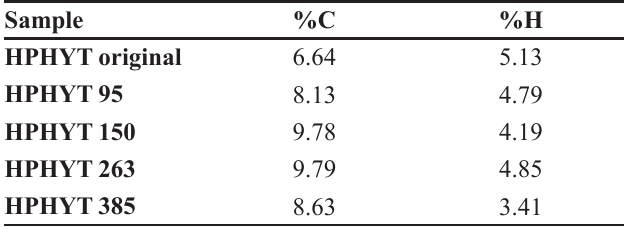
TABLE I - Results of elemental analysis for phytic acid (HPHYT) products isolated at different temperatures